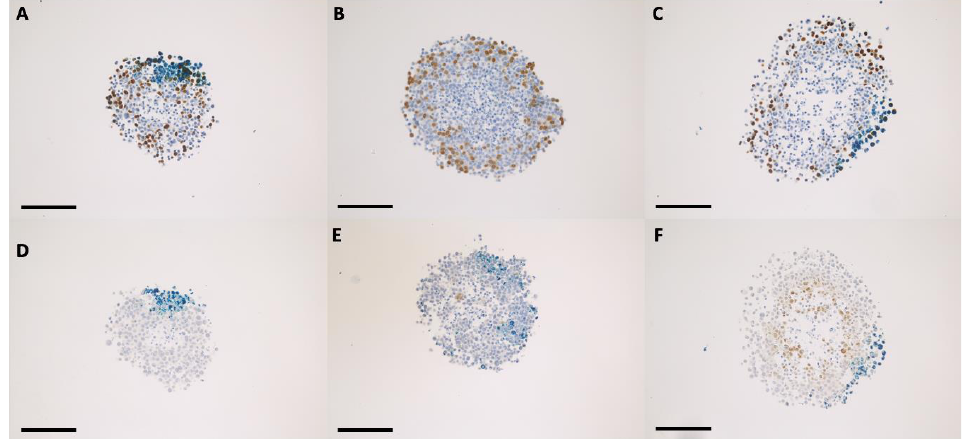
Figure 4. Bright-field microscopy images for HeLa spheroid sections that were previously incubated for 48 h with 200 μg/mL IONP DOX ; immunohistochemical staining of proliferative areas using bromodeoxyuridine ( A – C ), and of hypoxic areas using pimonidazol ( D – F ); light blue hematoxylin, dark blue IONP, dark brown proliferative cells, light brown hypoxic cells; measure bar is 100 μ m.